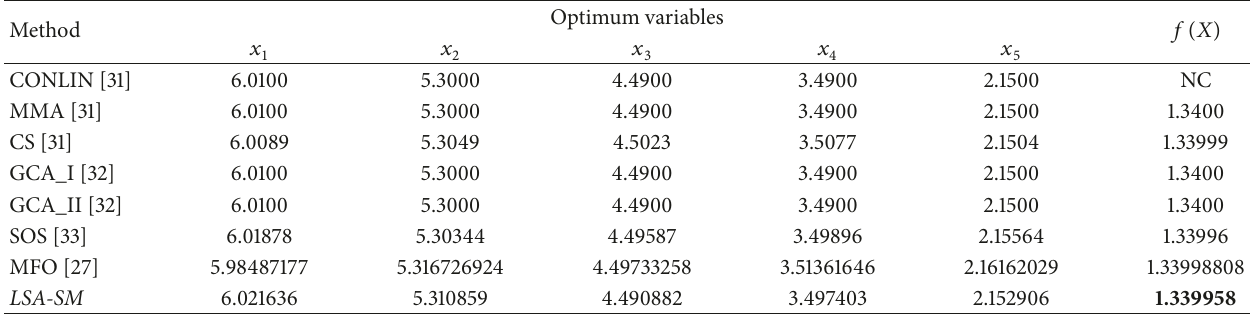
Table 9: Best results of the cantilever beam design by different methods.